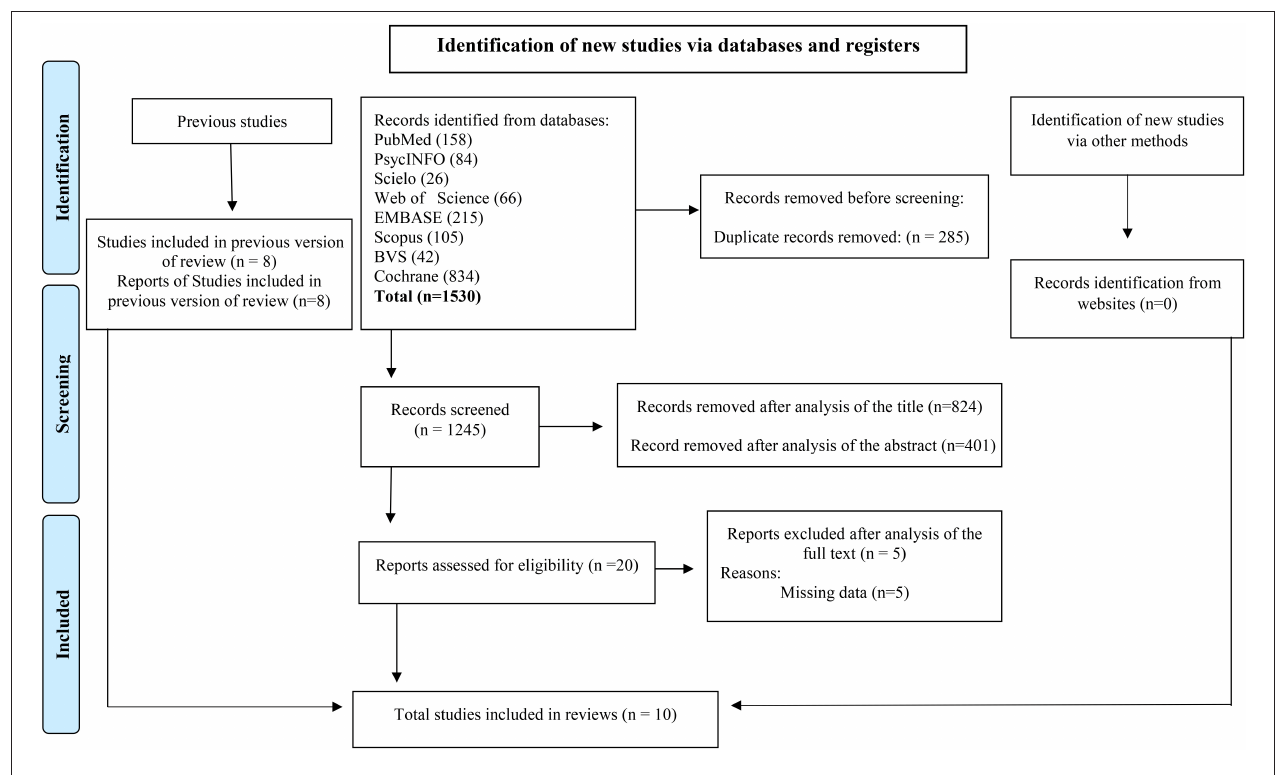
FIGURE 1 | PRISMA flow diagram for study